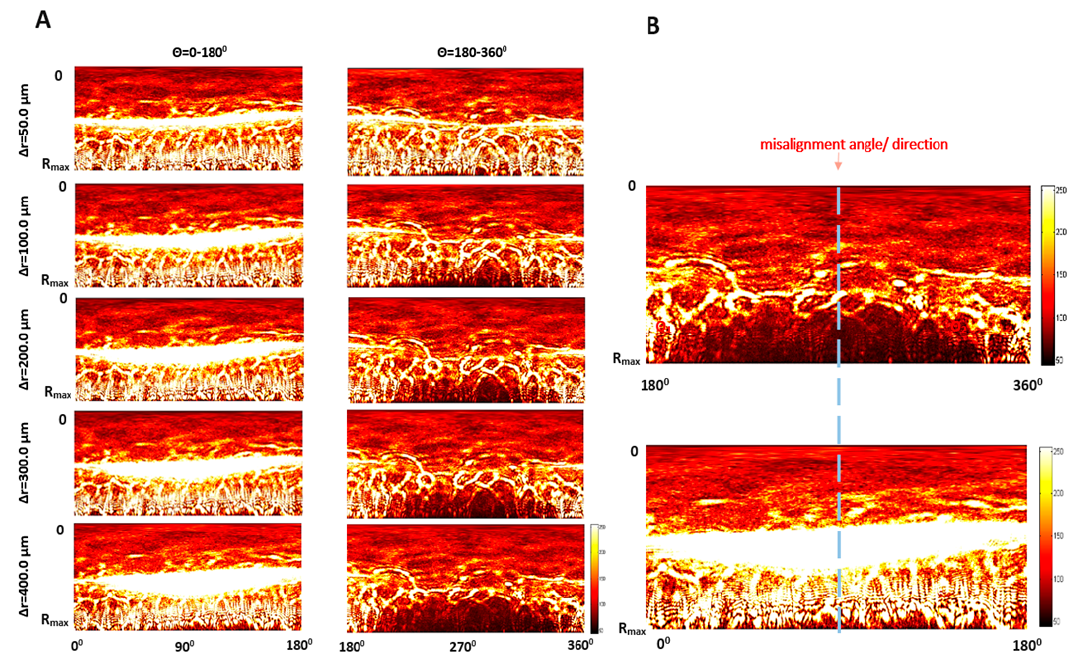
Figure 6. ( A ) The representative inverse polar images of the upper and lower parts of the diffraction patterns for different values of the ∆ r-parameter along the vertical direction ( Θ = 280°), ( B ) the concept of the use of diffraction pattern changes caused by the colony–illuminating beam misalignment for estimation of the misalignment direction for Θ = 180°–360°.